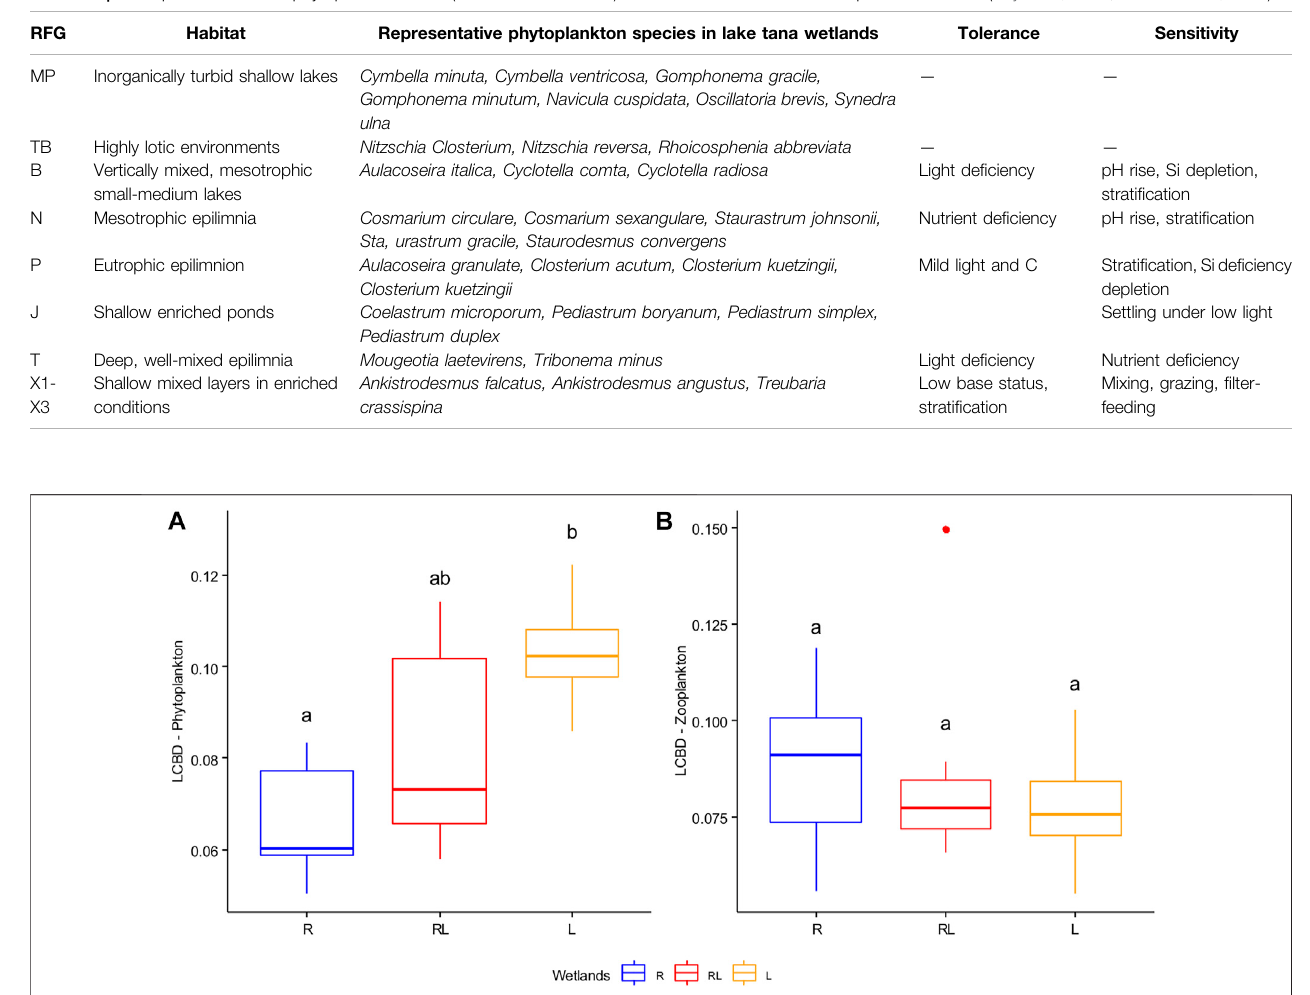
( Supplementary Table S6 ; Figure 8B ). LCBD of zooplankton for the entire data set ranged between 0.06 and 0.15 during the dry season and between 0.07 and 0.10 during the wet season. Although three of the four wetlands of riverine papyrus swamps (Amba-giorgis, Dehna-mesenta, and Legdiya) contributed more than the average to zooplankton BD Total (LCBD), there was no signi fi cant difference between wetland types ( Supplementary Table S2 ; Figure 8B ). For all data, the Megech river mouth wetland was statistically signi fi cant for single wetland